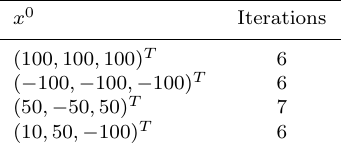
Table 2. Iterations of Algorithm 1 with the different starting points x 0 . x